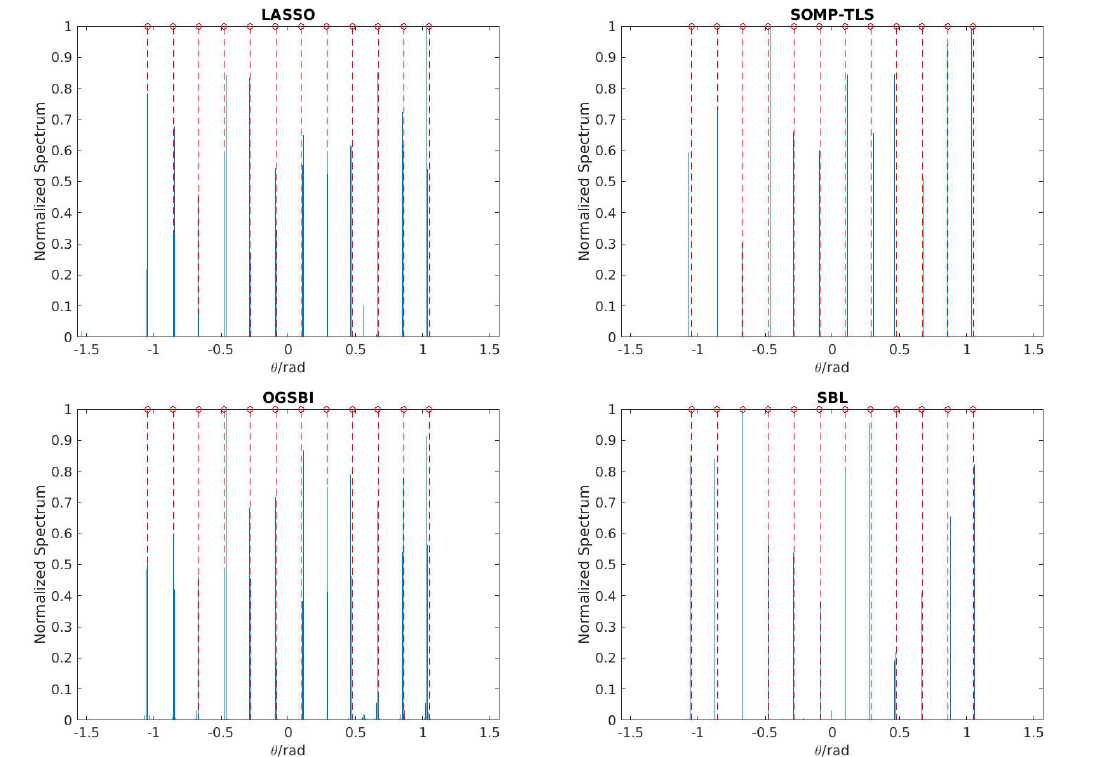
Figure 2. Normalized spectra for least absolute shrinkage and selection operator (LASSO), simultaneous orthogonal matching pursuit total least squares (SOMP-TLS), off-grid sparse Bayesian inference (OGSBI) and Sparse Bayesian learning (SBL) with T = 100 and signal-to-noise ratio ( SNR ) = 0